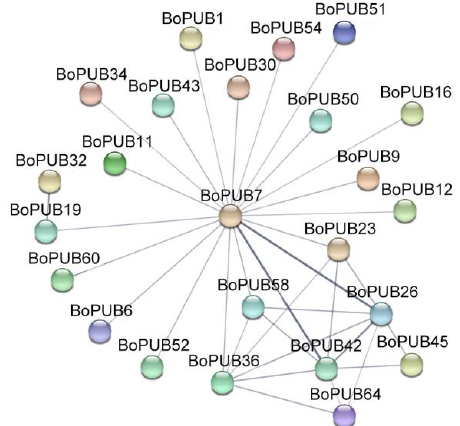
Figure 4. Prediction of interactions between BoPUB proteins. Grey lines indicate putative interactions between BoPUB proteins, and the depth of line color represents the possibility of protein–protein interaction. Three-dimensional spheres represent BoPUB proteins.